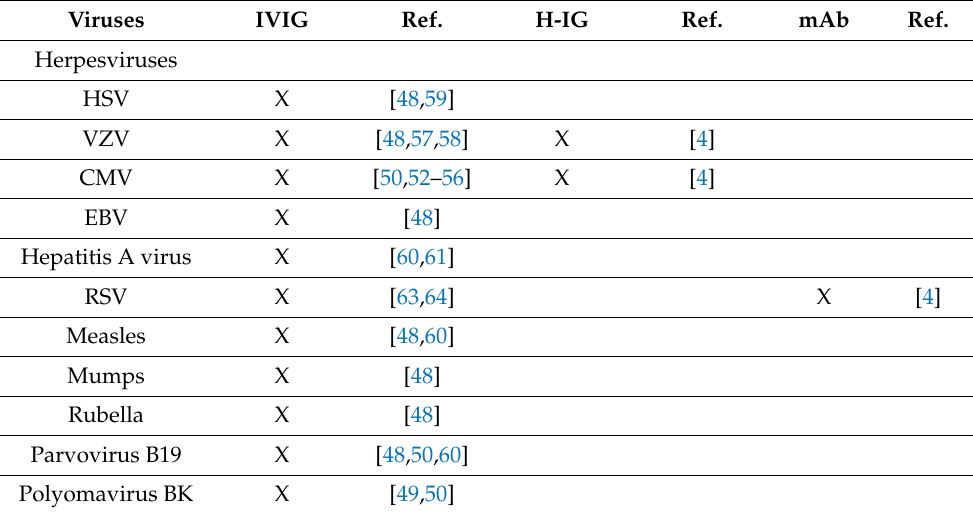
Table 1. Passive immunotherapy in viral infectious diseases. Viruses IVIG Ref. Ref.